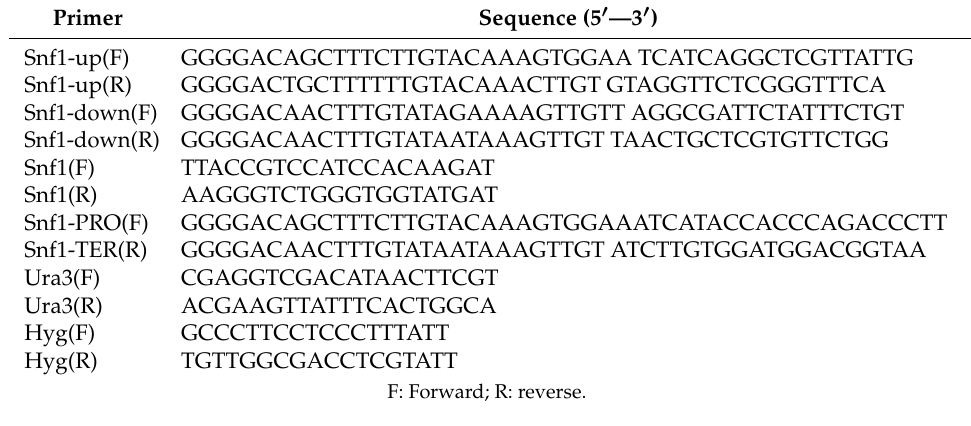
Table 1. Primers used in this